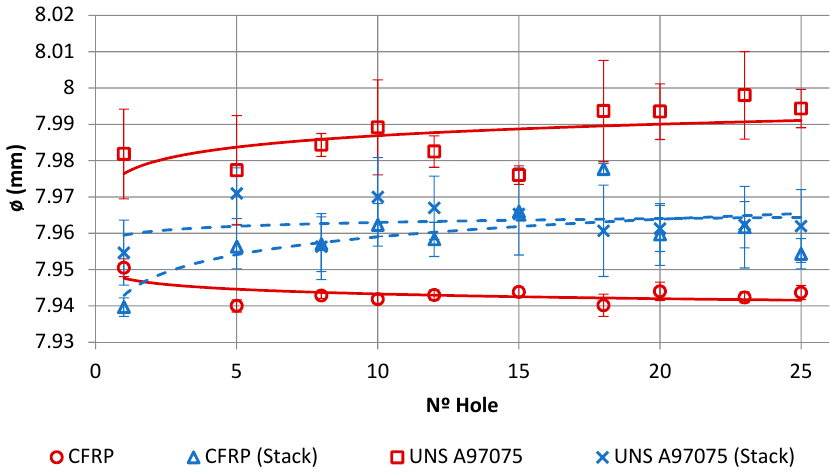
Figure 18. Evolution of hole diameter with number of holes.